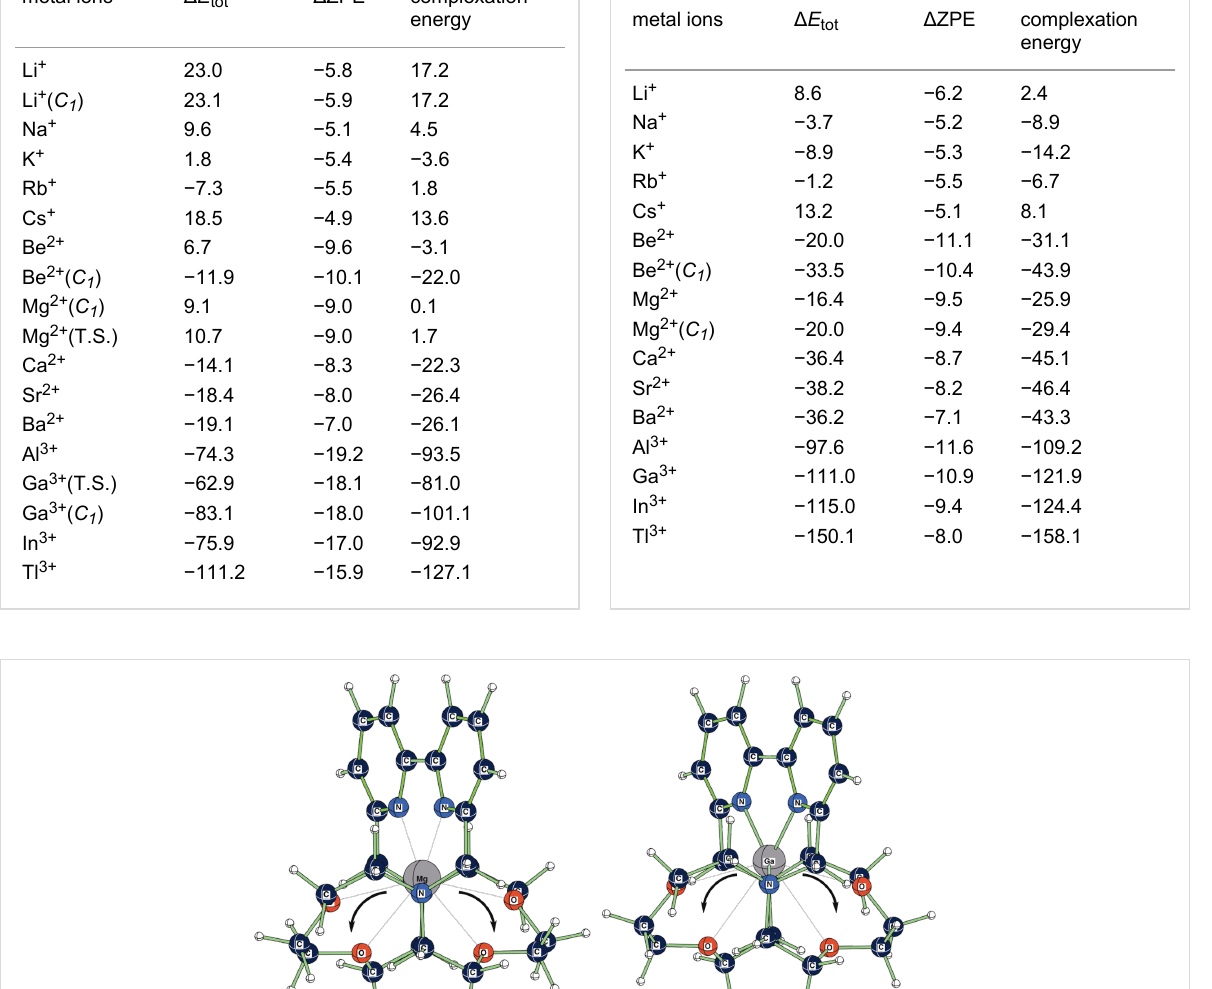
Table 3: Energy contributions (kcal/mol) to the complexation energy for [M 2.2.bpy] m+ (RB3LYP/LANL2DZp).